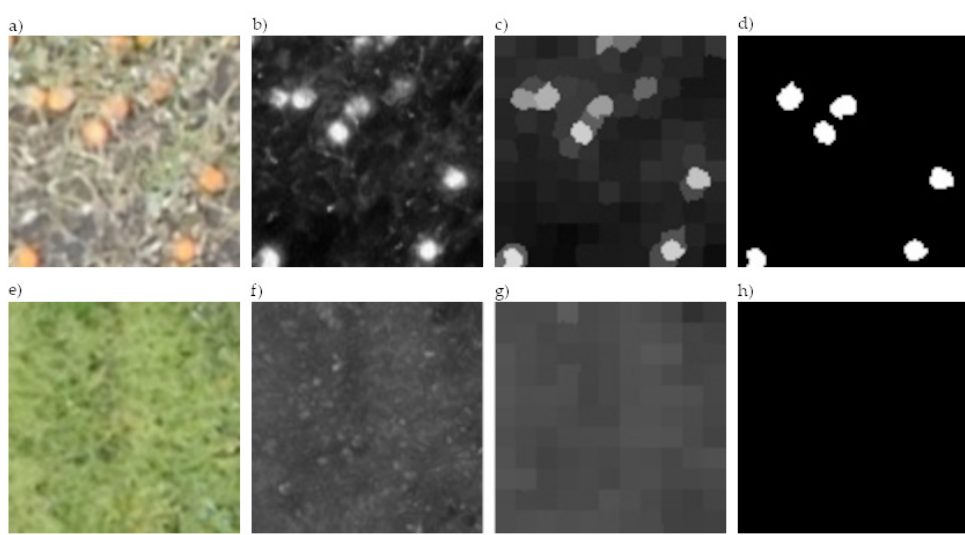
Figure 3. Reference tile with pumpkins ( a ), its saturation band ( b ), segmented image ( c ), and thresholded image ( d ). Reference tile without pumpkins ( e ), its saturation band ( f ), segmented image ( g ), and thresholded image ( h